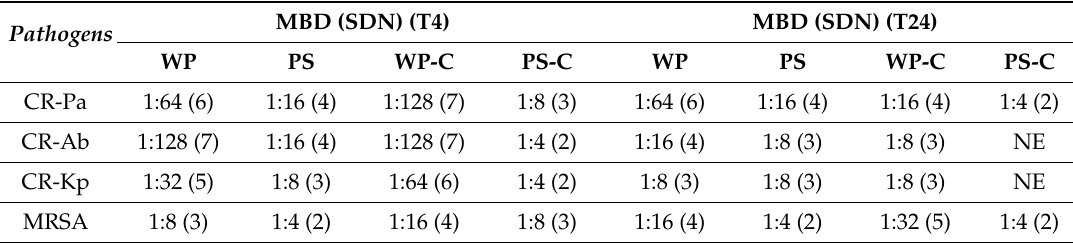
Table 1. Antibacterial activity of probiotic whole compound (WP) and probiotic cell-free surnatant (PS), alone and after co-incubation with the pathogen at 4 h (T4) and 24 h (T24) against clinical strains of carbapenem-resistant (CR) P. aeruginosa (Pa), CR A. baumannii (Ab), CR K. pneumoniae (Kp), and methicillin-resistant S. aureus (MRSA) with and without co-incubation with the pathogen. MBD = minimal bactericidal dilution. SDN = Serial Dilution Number (number of the serial 2-fold WP and PS dilutions needed to obtain the corresponding MBD). WP-C = WP after co-incubation; PS-C = PS after co-incubation; NE = no e ff ect. Results were expressed as mean. Standard deviation (SD) is not represented since the values of the experiments (performed in duplicate) were the